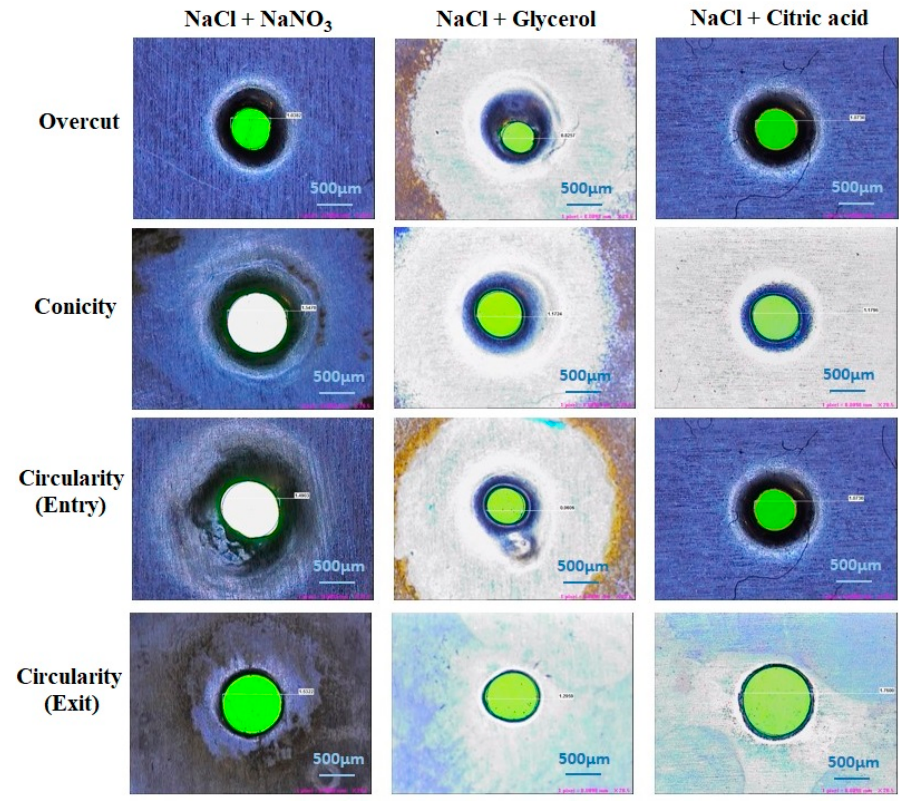
Figure 2. Effects of different electrolyte combinations on quality measures.